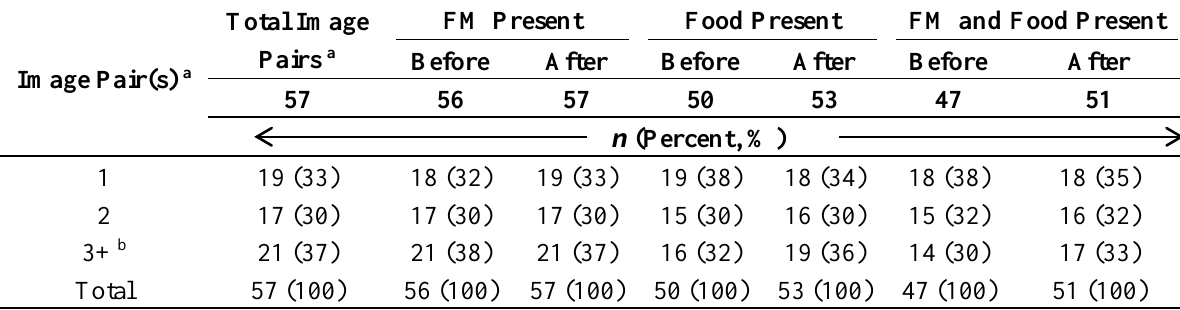
Table 2. Descriptive data of usable image pairs by number of image pairs captured using the mobile food record among children, 3–10 years old, in Sample 1 ( n = 57 children) attending summer camps in Guam during